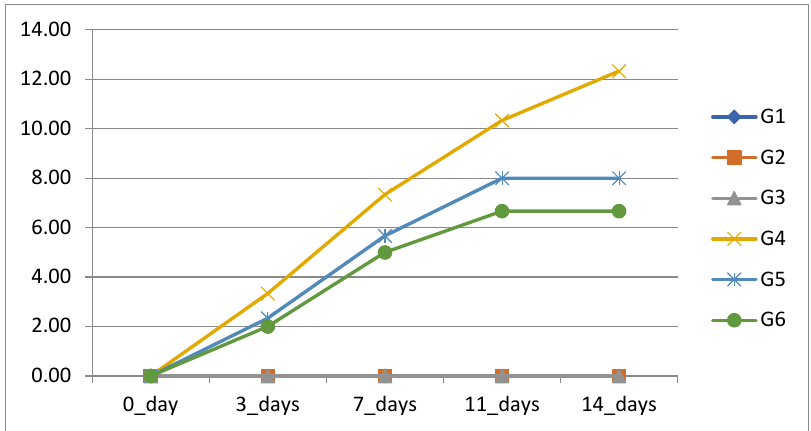
Figure 2. Cumulative mortality percentage (CM%) of Nile tilapia in response to formic acid and carvacrol supplementation after challenge with P. putida .